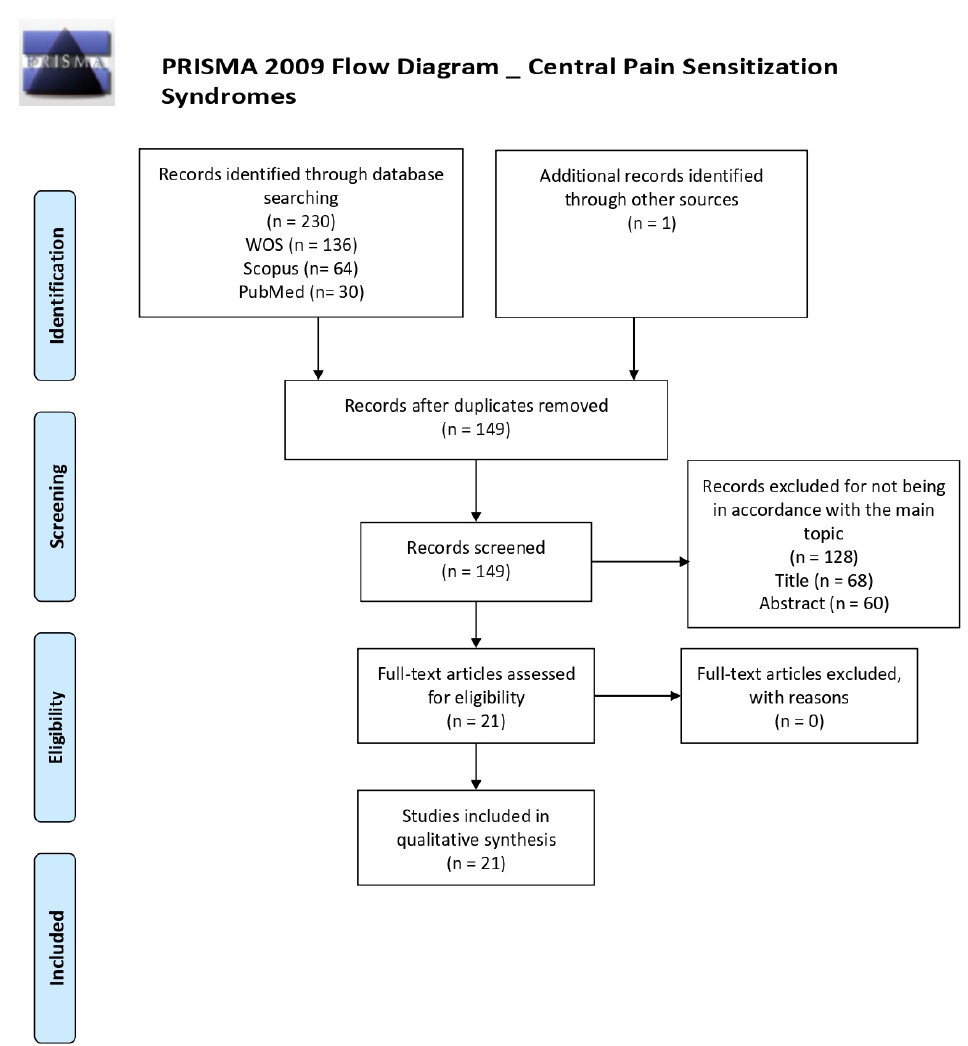
Figure 1. Flow diagram of Central pain sensitization syndromes.